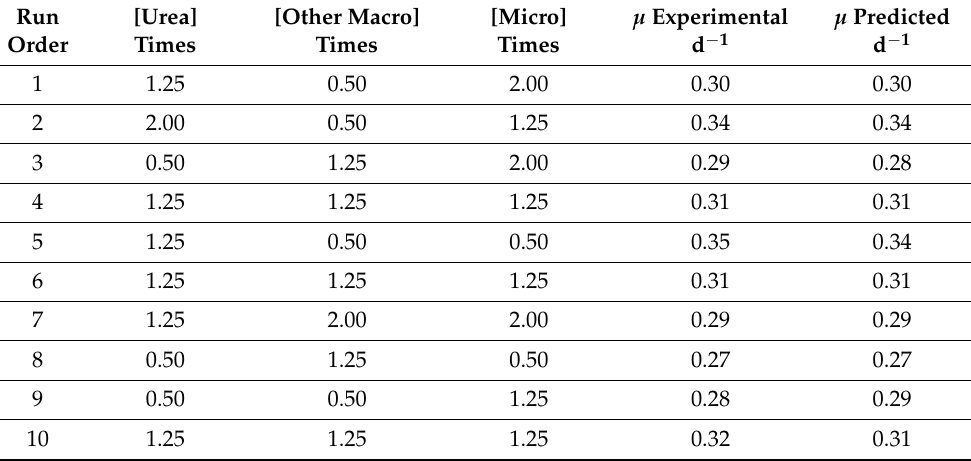
Table 5. Experimental layout of the Box–Behnken design and the results of the experimental and predicted specific growth rates ( µ ) of the photoautotrophic